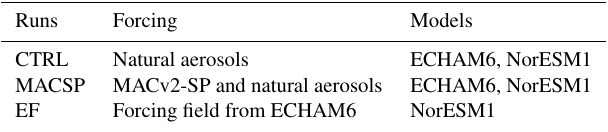
Table 1. Summary of the performed model